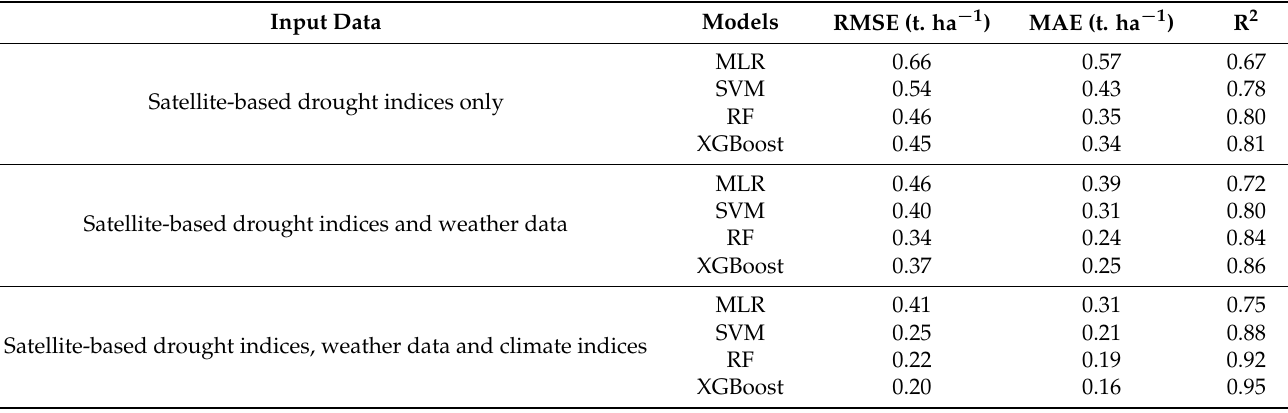
Table 3. Statistical metrics of the forecasting models for several input data combination and for the 4 methods in April (1 month before harvest). All available input data from October to April were used (see Table 2). The metrics are computed for the 15